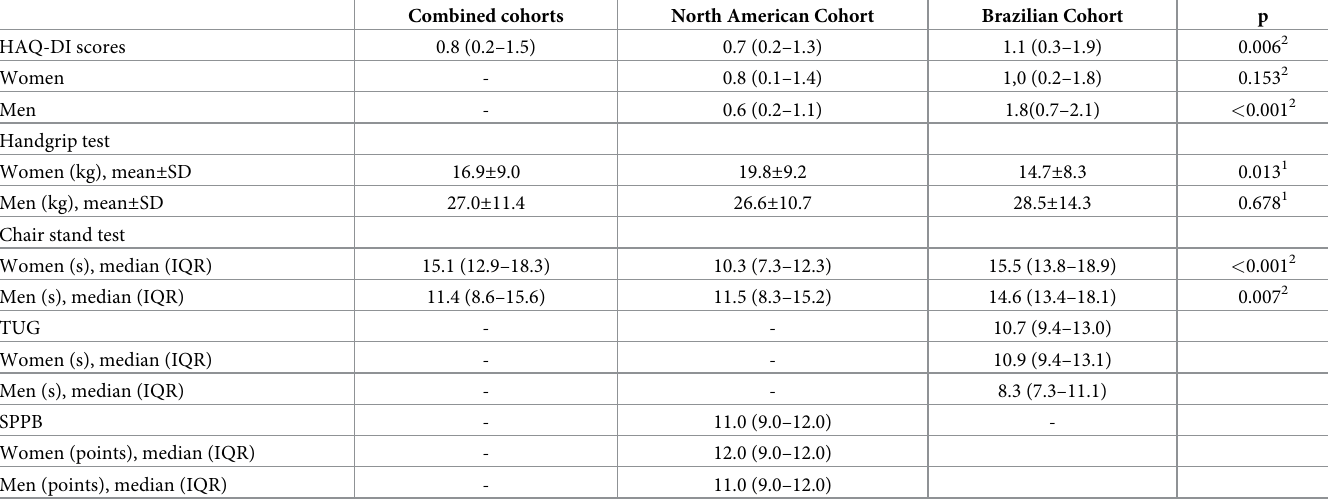
Table 2. Descriptive data of physical function, muscle strength and physical performance on the two